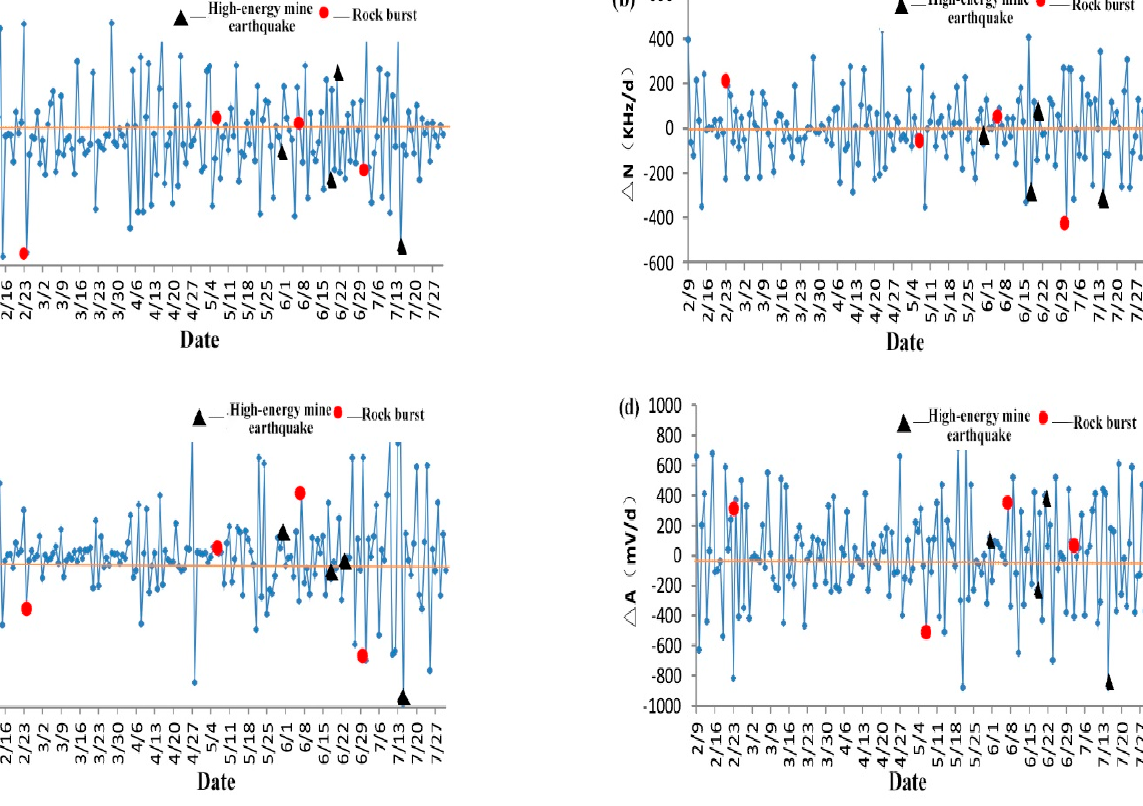
Figure 10. Time fluctuation gradient curve of 73005# working face. ( a ) ∆ E. ( b ) ∆ N. ( c ) ∆ R. ( d ) ∆ A. By analyzing the Figure 10, it is found that ∆ E, ∆ N, ∆ R, and ∆ A fluctuate up and down in a certain range around the value of 0. The temporal variation rules of four